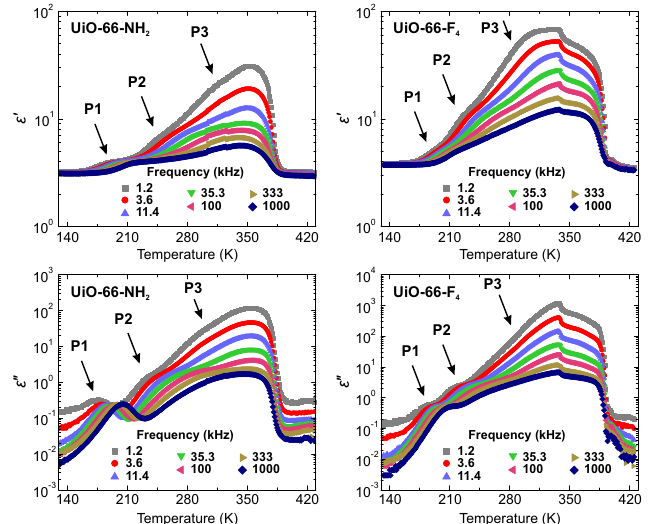
Figure 2. Temperature dependence of the complex dielectric permittivity of UiO-66-NH hydrated powder samples at several selected frequencies. Three processes, P1, P2 and P3, related to the adsorbed water are indicated by the arrows. Measurements performed on